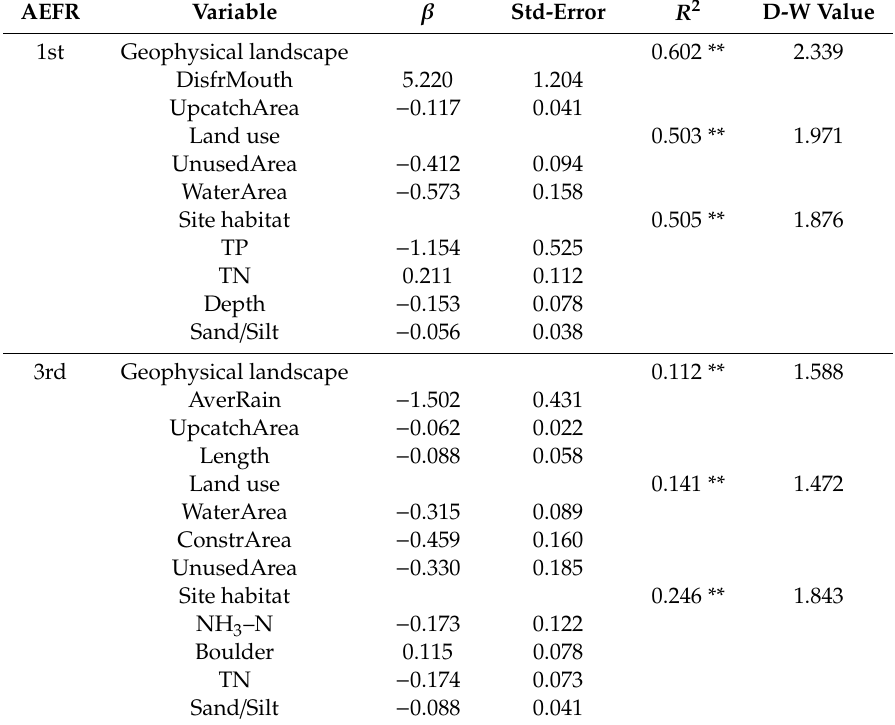
Table 3. Geophysical landscape, land use, and site habitat MLRs of macroinvertebrates in the first level-I